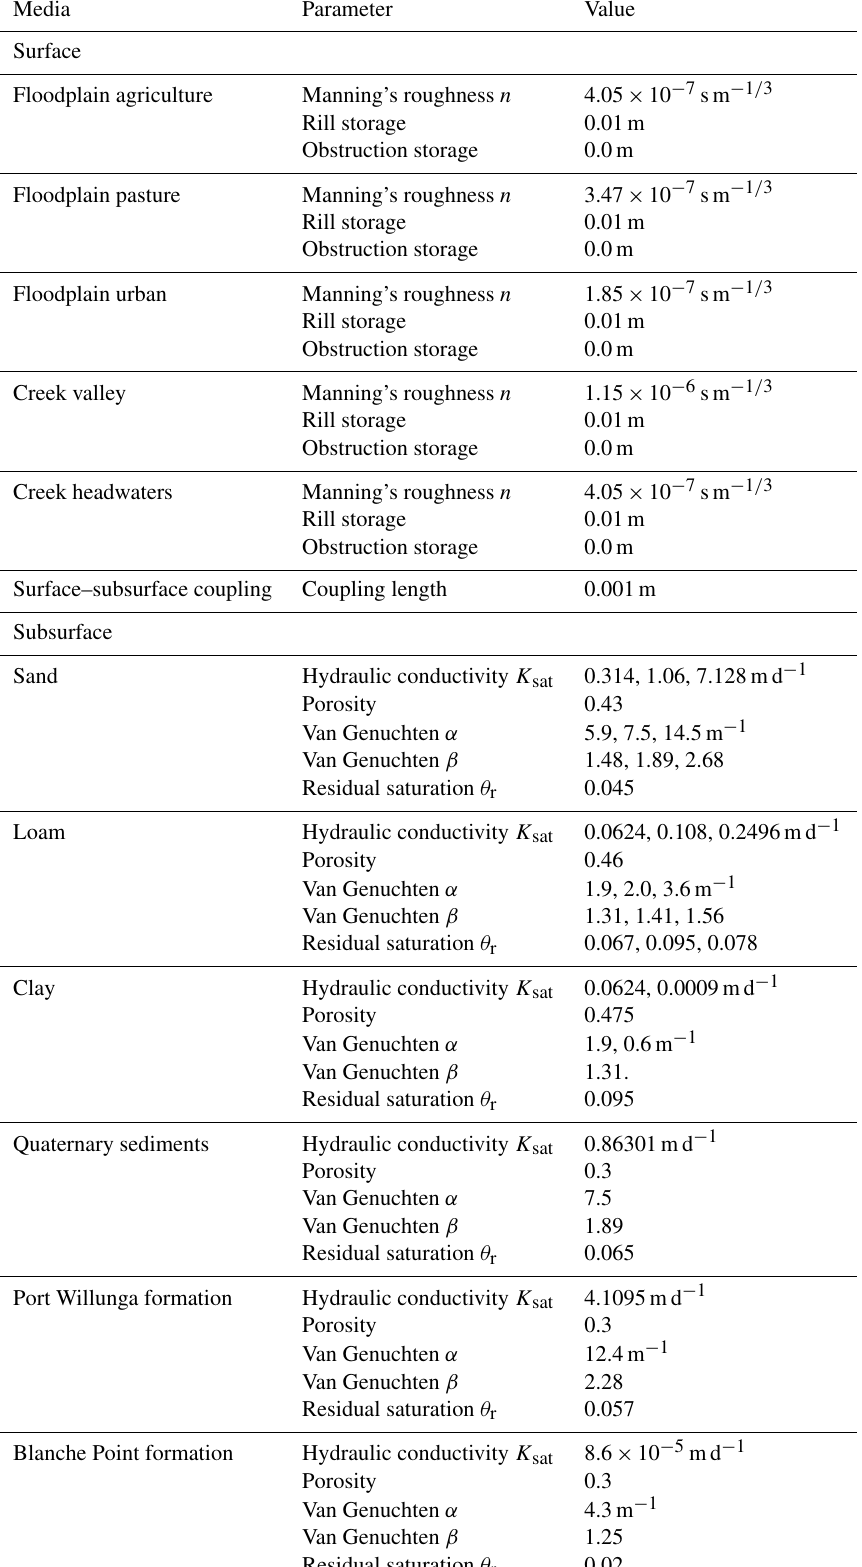
Table 3. Surface–subsurface parameters for Pedler Creek. See Fig. 1 for land use